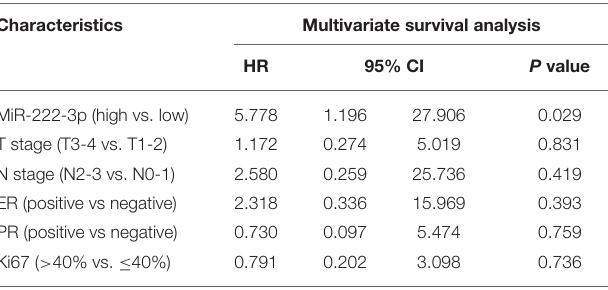
TABLE 3 | Multivariate survival analysis of serum miR-222-3p and DFS. Characteristics